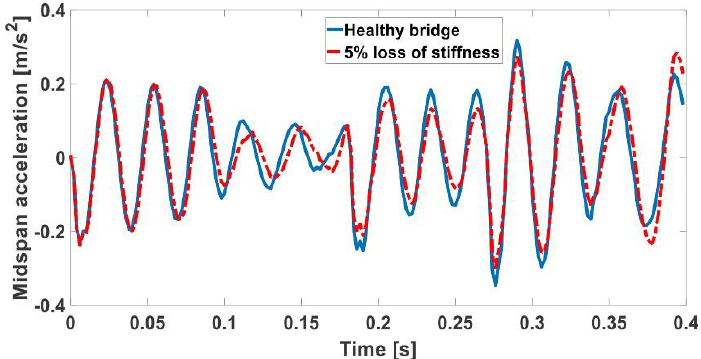
Figure 8. Effect of bridge damage in the mid-span bridge acceleration using the class ‘A’ road profile.